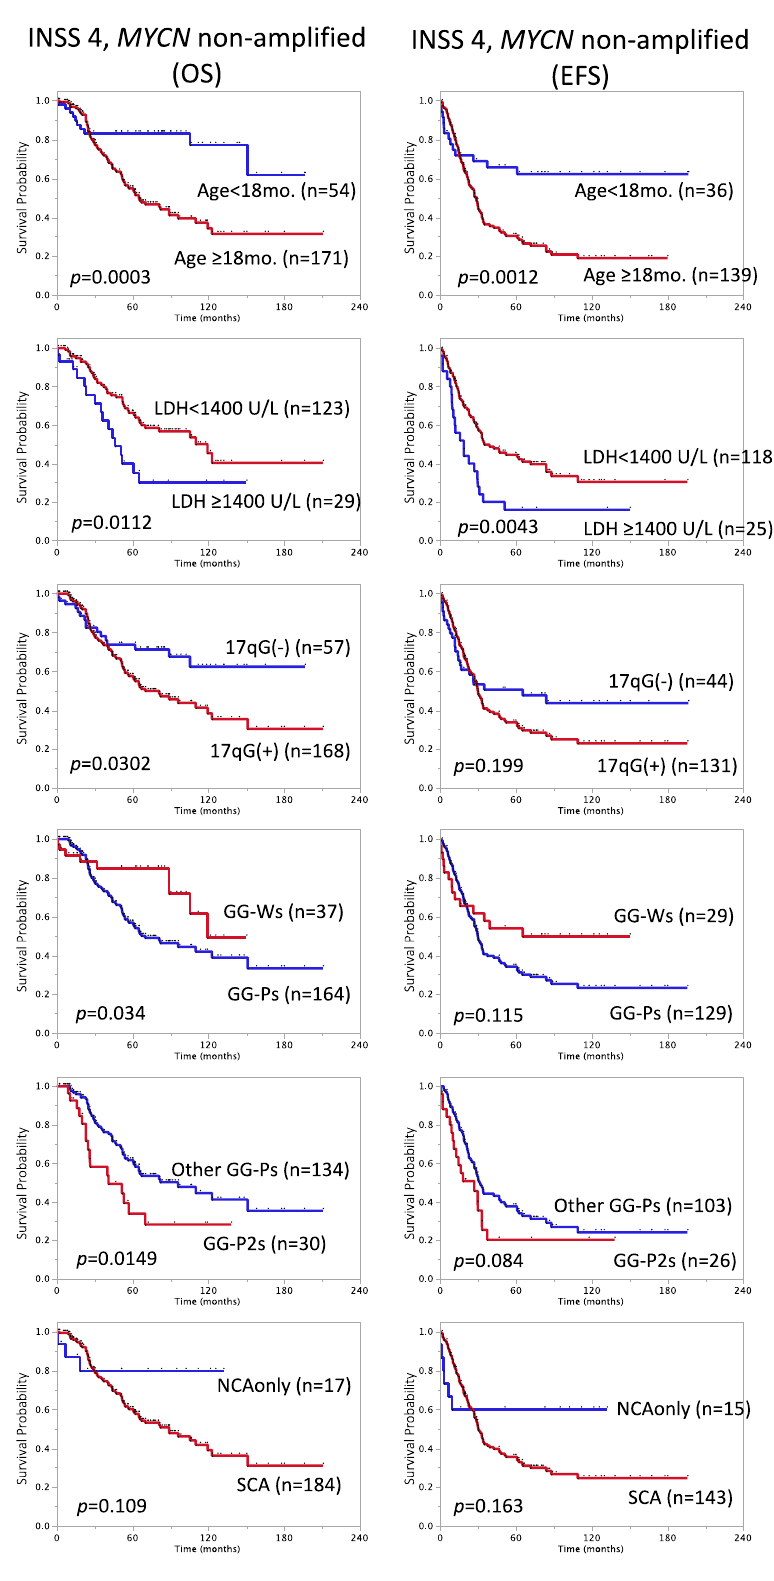
Figure 3. Kaplan–Meier survival curves of patients with stage 4, MYCN non-amplified tumors divided by clinical and genomic factors. OS ( left ) and EFS ( right ). OS: overall survival; EFS: event-free survival; mo.: months; GG: genome group; Other GG-Ps: GG-Ps (but no GG-P2s); NCA: numerical chromosome aberration; SCA: segmental chromosome